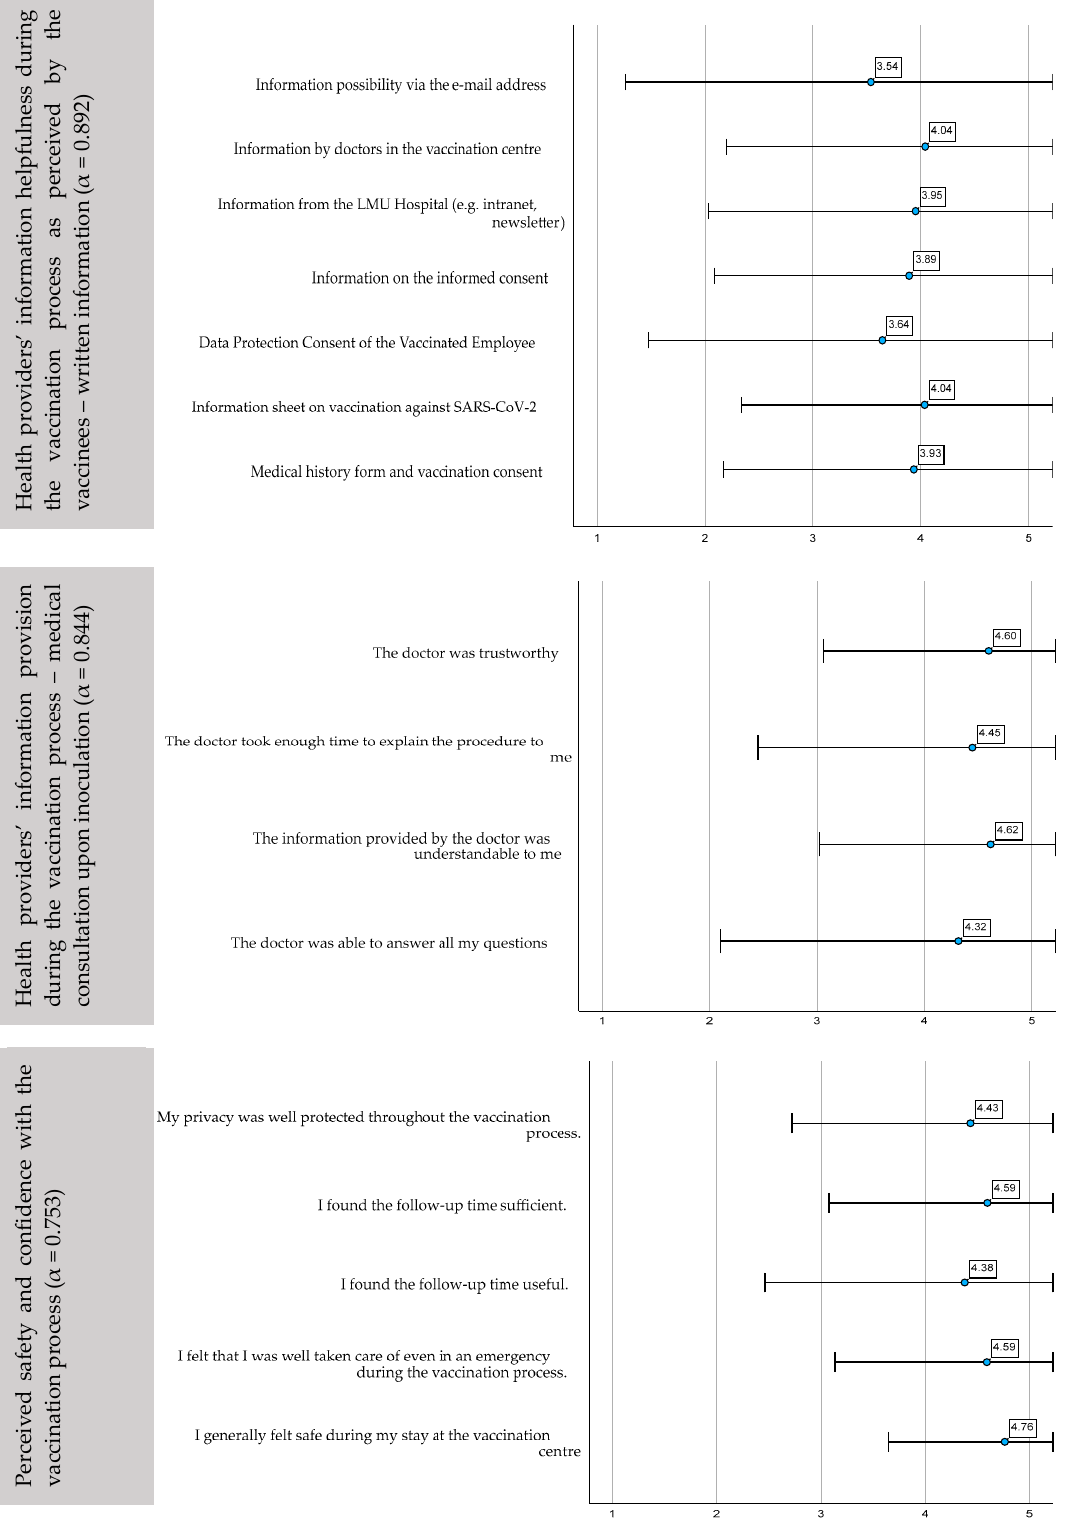
Figure 2. Individual and group influences: health providers’ information quality and helpfulness during the vaccination process as perceived by the vaccinees—written information ( α = 0.892), medical consultation upon inoculation ( α = 0.844) and perceived safety and confidence with the vaccination process ( α = 0.753). Mean values, standard deviation of the answers on the five-point Likert scale and Cronbach’s